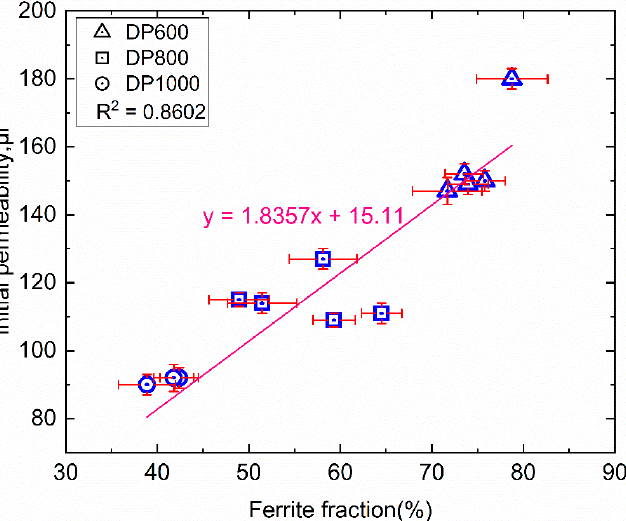
Figure 8. Initial permeability versus ferrite fraction for the commercial DP600, DP800 and DP1000 steels.